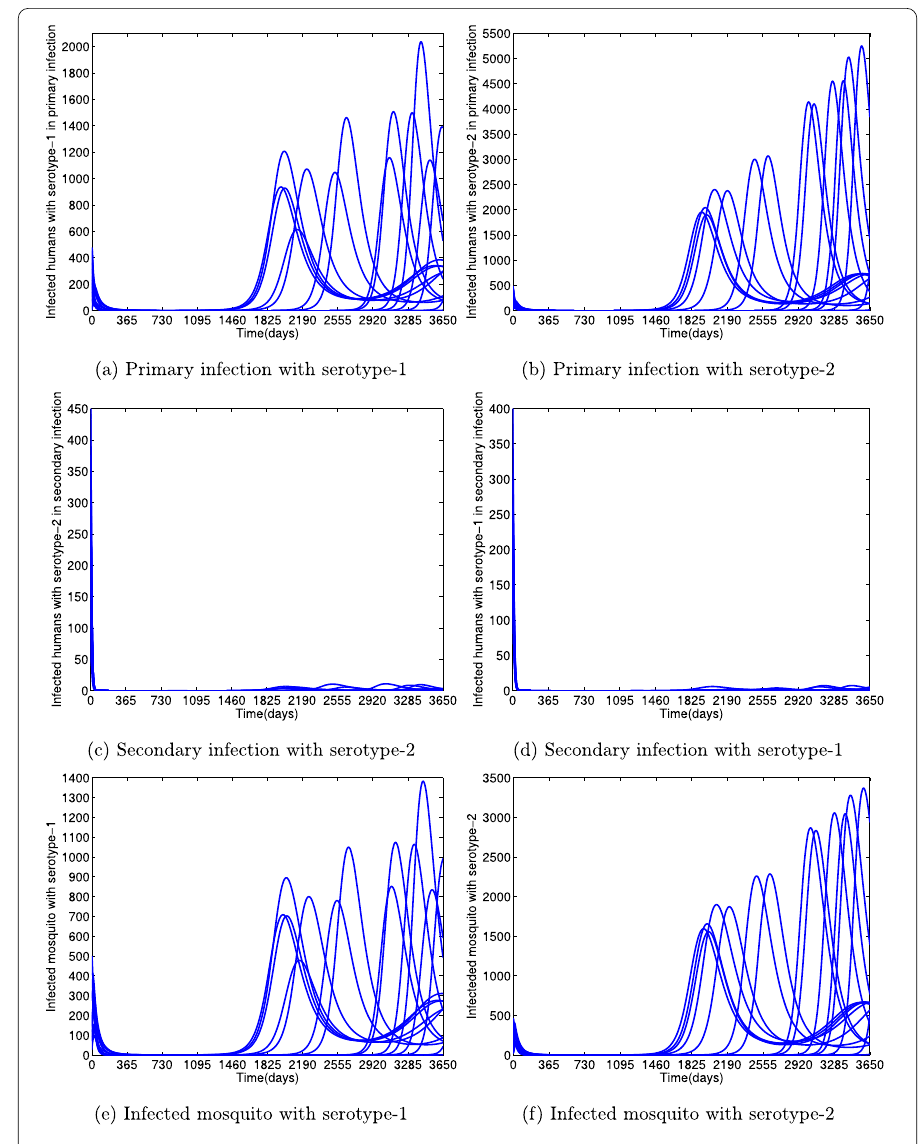
Figure 8 Time series plots of the number of infected humans and mosquitoes predicted by the multi-serotype dengue model (2.4)–(2.5) with different initial sizes of the sub-populations. The values of model parameters used are given in Table 2 and λ = 1.3699 × 10 –3 which corresponds to two years of cross immunity after primary experience infection